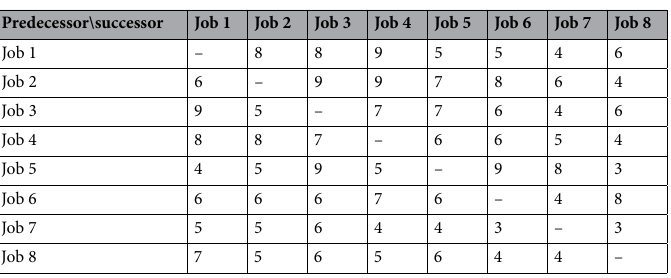
Table 4. The sequence-dependent setup times of the